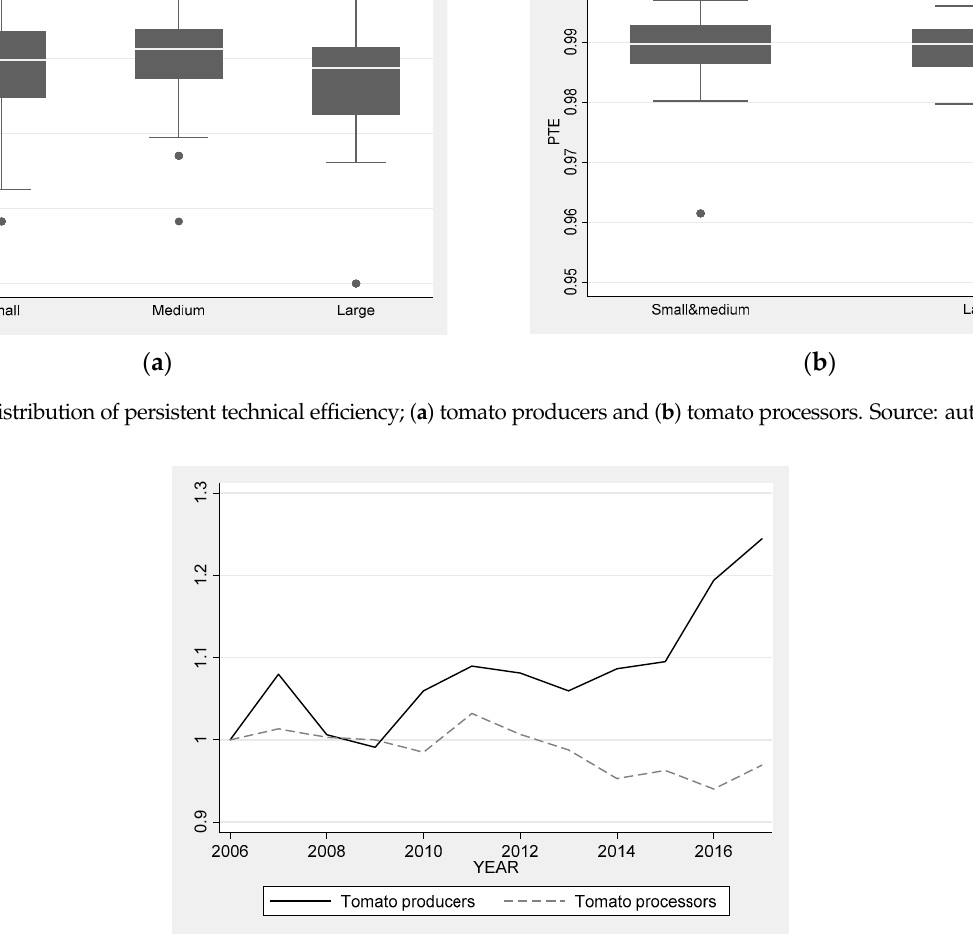
Agriculture 2021 , 11 , x FOR PEER REVIEW